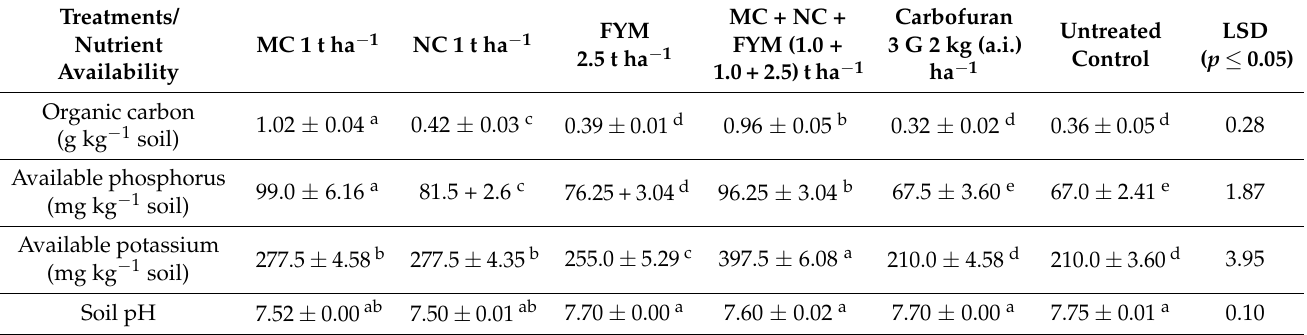
Table 6. Effect of the application of amendments on soil properties and nutrient availability (polyhouse-I, Department of Plant Pathology).